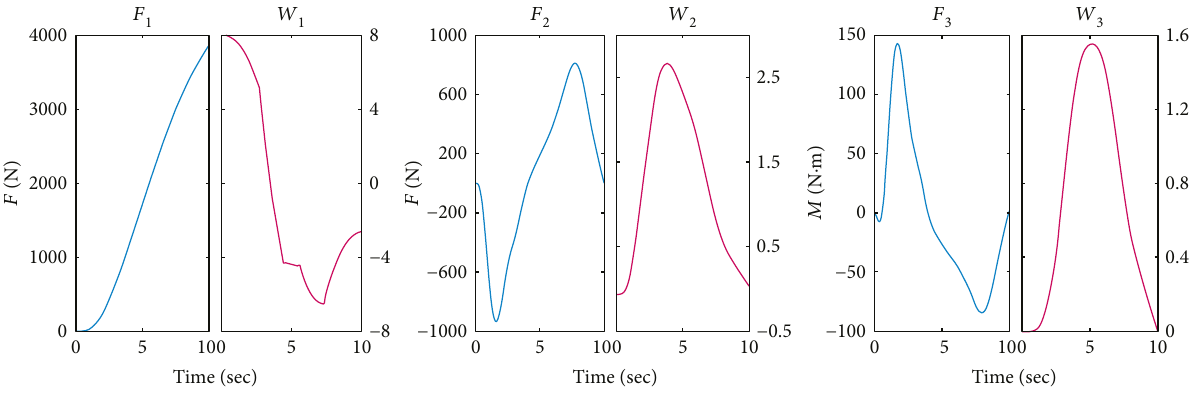
Figure 9: Conventional dynamic versus additional